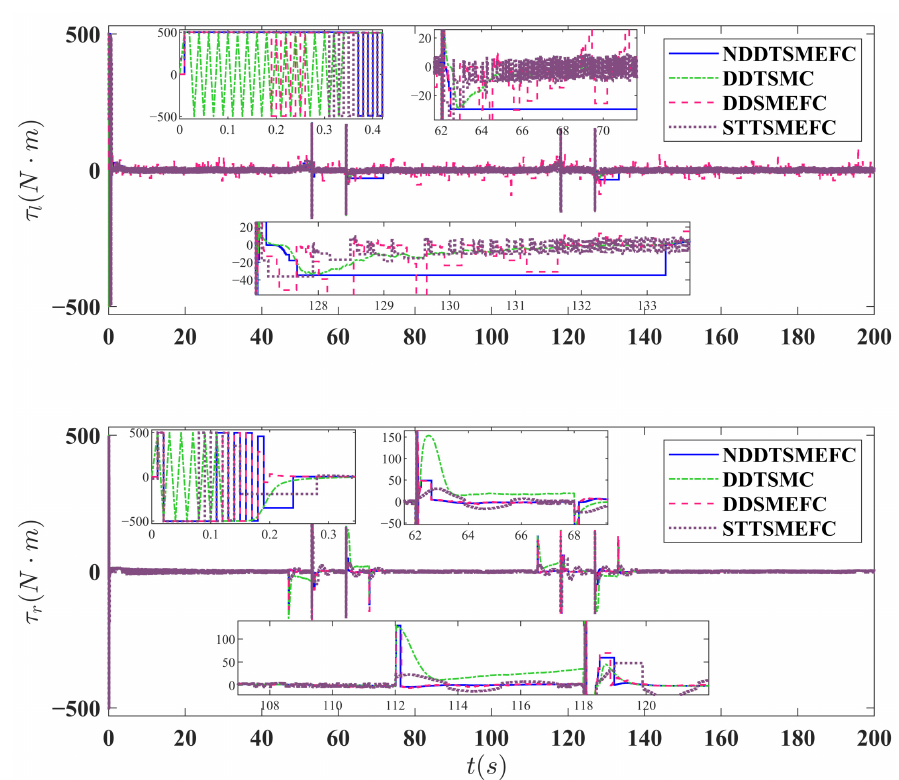
Figure 8. Schematic diagram of UTRO system